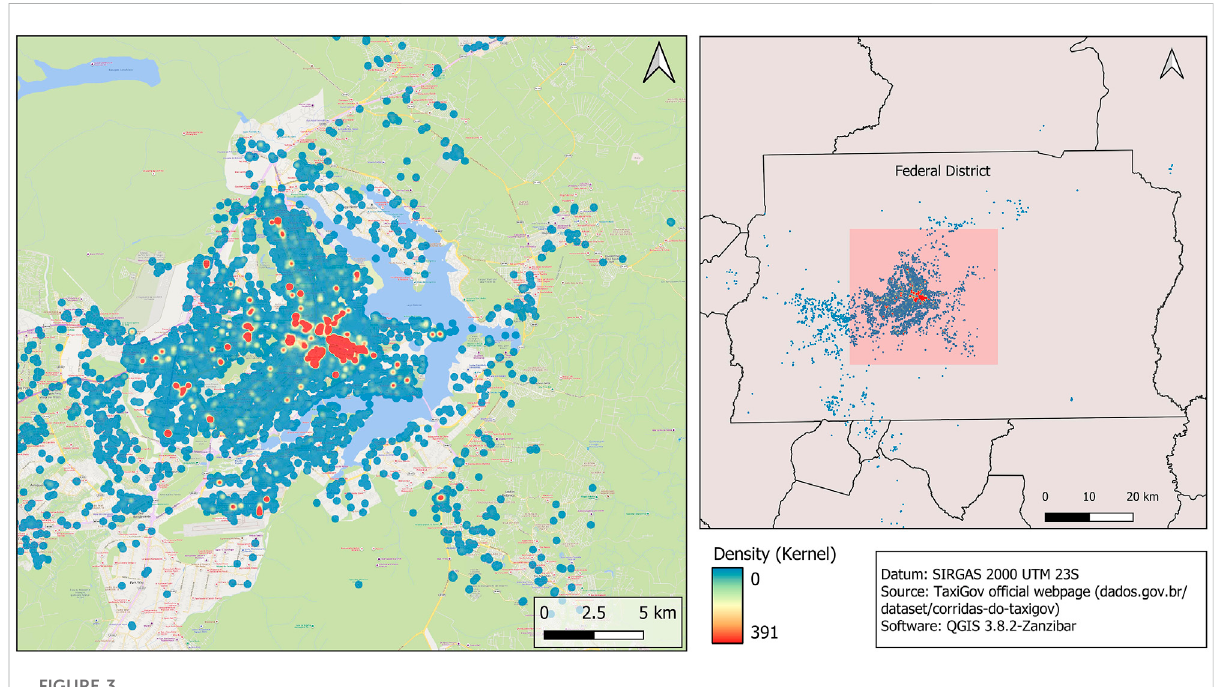
FIGURE 3 Heatmap of the most common origins of meeting trips in the RIDE.